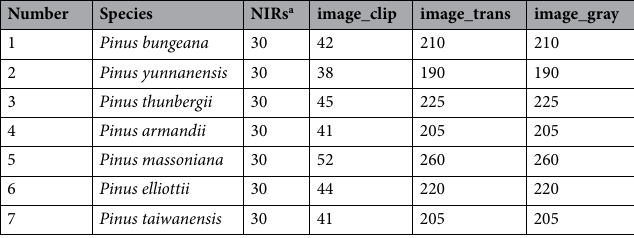
Table 7. Pine nut images and NIR spectra. a NIRs, the number of NIR spectra.